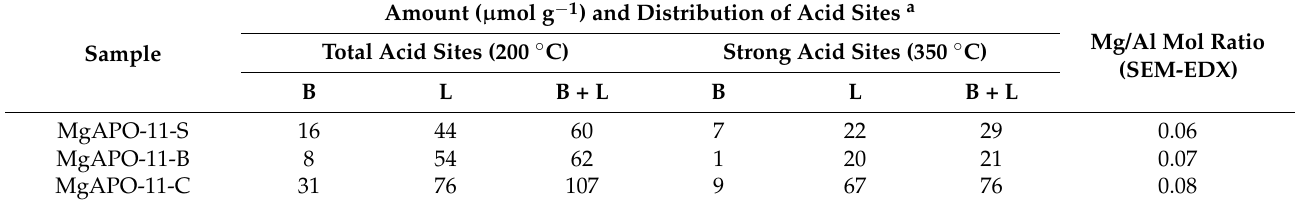
Figure 1. SEM images of the three MgAPO-11 samples. Table 1. Acid amount and distribution of the acid sites of the MgAPO-11